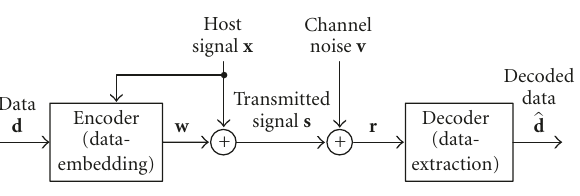
Figure 5: A general model for data communication by